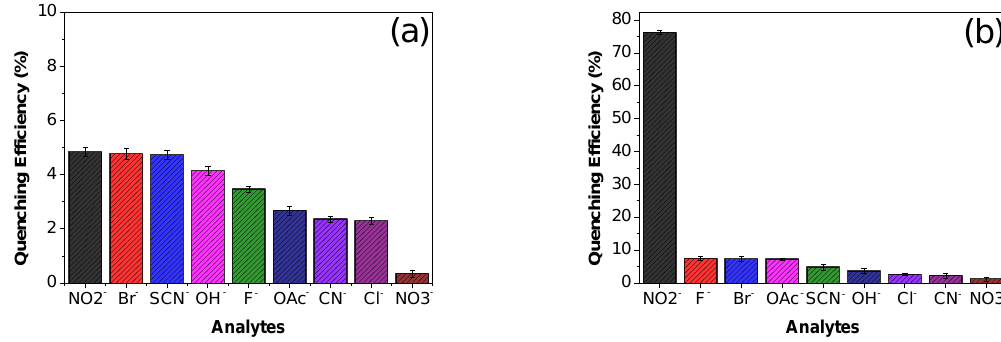
di ff erent Na + salts in aqueous Figure 5. Quenching efficiency of ( a ) Eu 3+ /PSA (λ em = 616 nm) and ( b ) Tb 3+ /PSA (λ em = 545 nm) with different Na + salts in aqueous solution.